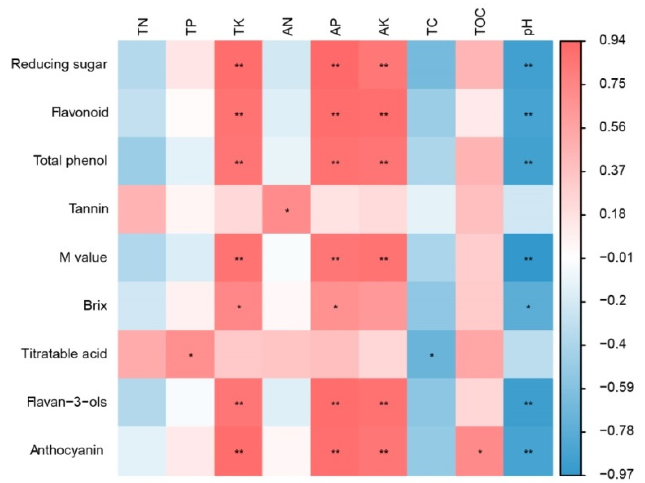
Figure 11. Correlation analysis between soil property and fruit quality. Note: * means the two indicators are significantly different at the 0.05 level ( p < 0.05); ** means the two indicators are extremely significantly different at the 0.01 level ( p <